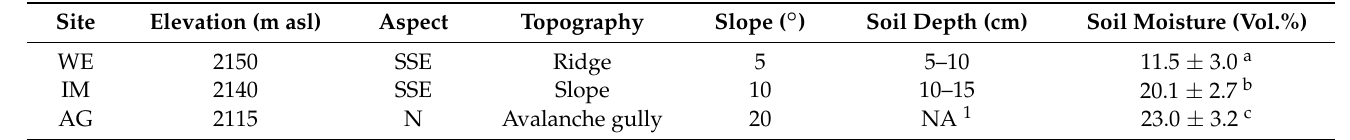
Table 4. Description of selected study sites (WE = wind-exposed ridge; IM = intermediate site; AG = avalanche gully; asl = above sea level). Statistically significant differences of mean values among sites are indicated by different letters ( p ≤ 0.01; Student’s t